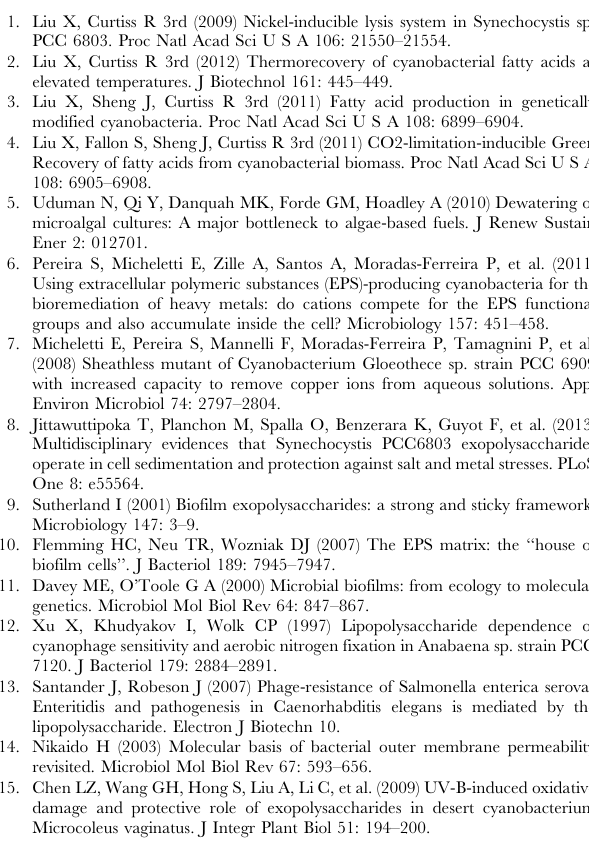
Table S1 Gene products potentially involved in the synthesis and assembly of the Synechocystis cell wall and cell-surface macromolecular components.